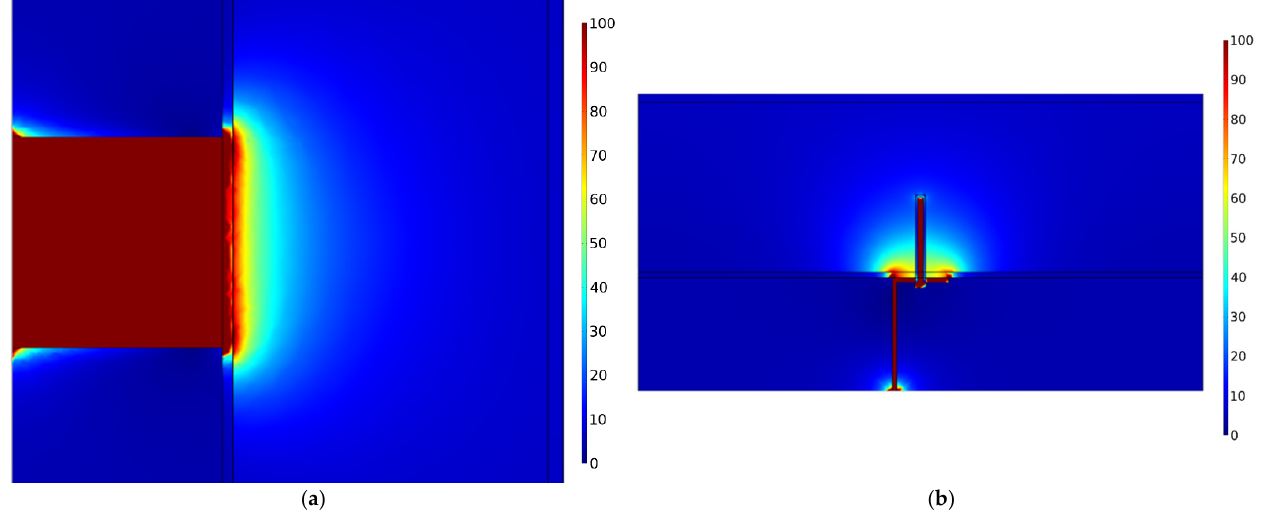
Figure 5. Heat flux density (W/m 2 ) in 2D vertical ( a ) and horizontal ( b ) sections.